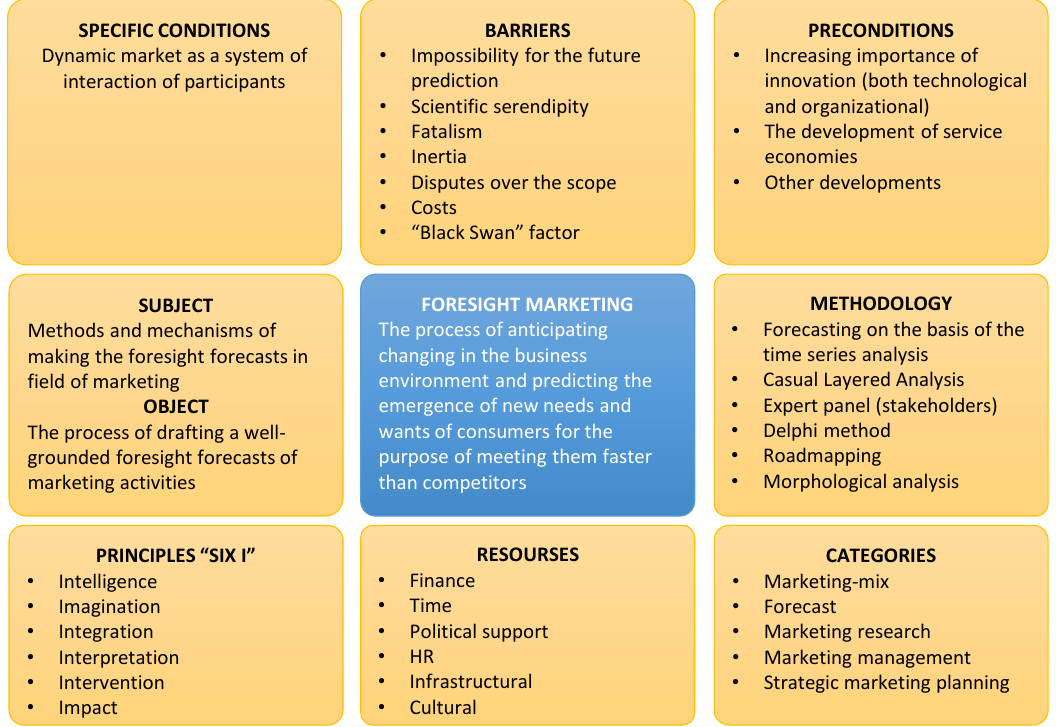
Figure 3. The foresight marketing